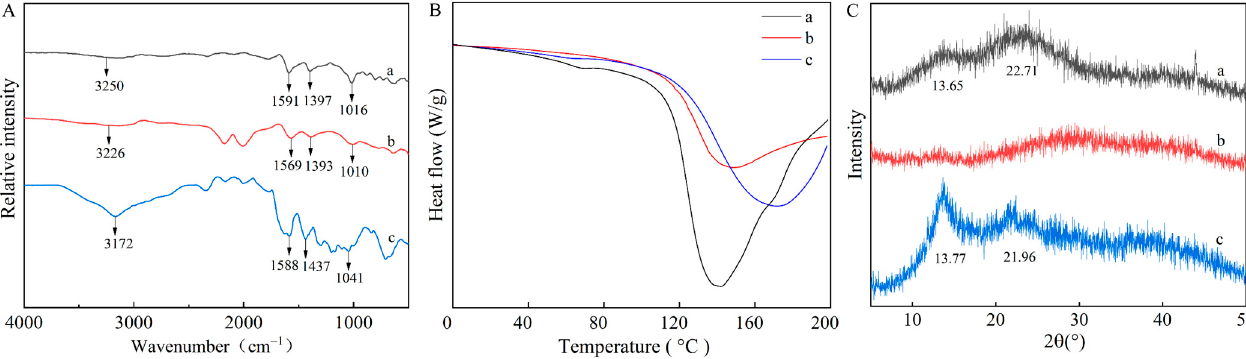
Figure 5. FTIR ( A ), DSC ( B ), and XRD ( C ) data for sodium alginate (a), empty hydrogel (b), and MeSA hydrogel (c).